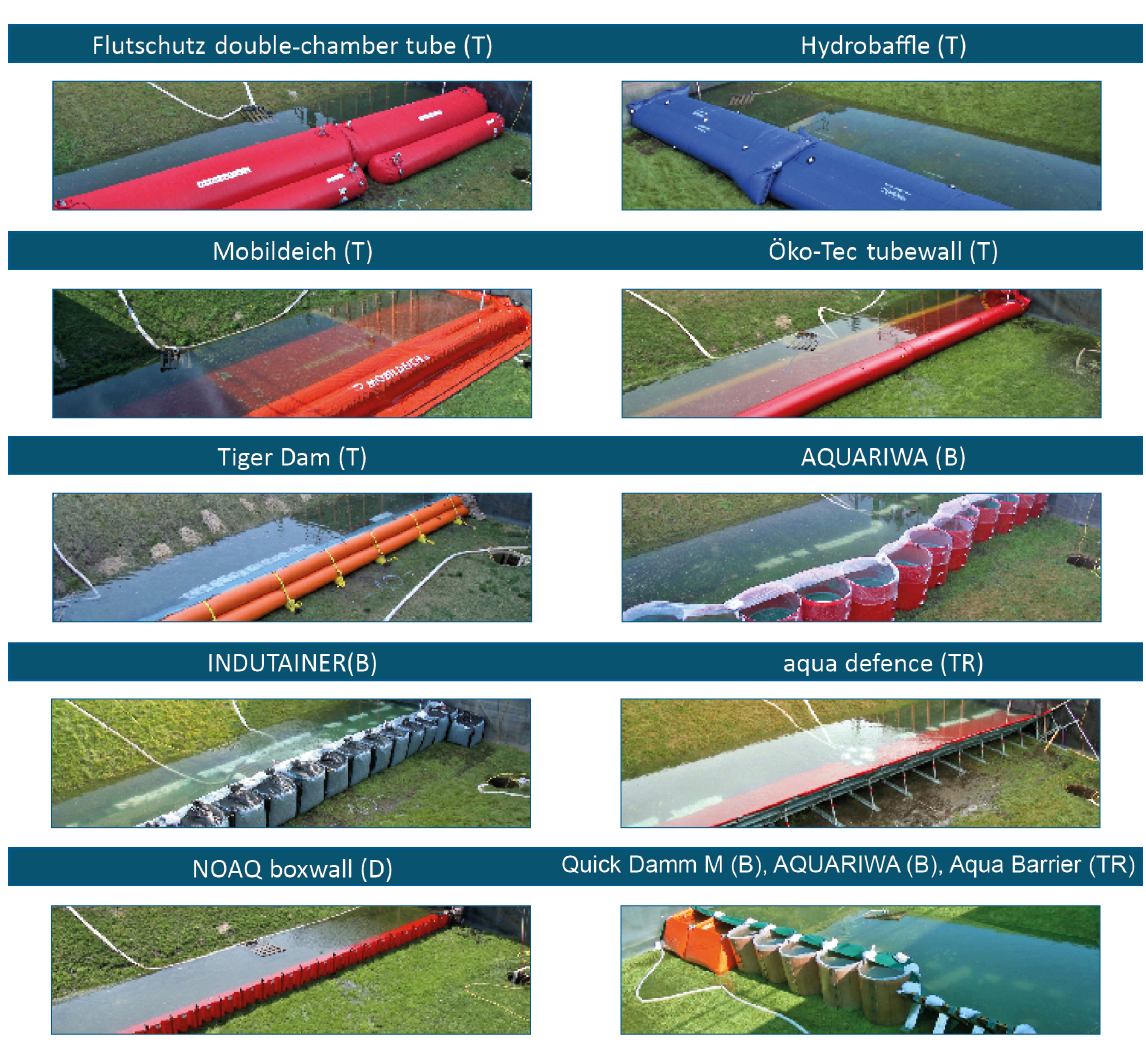
Figure 5. The various SBRSs tested. (T) is tube system, (B) is basin system, (D) is dam system and (TR) is trestle system.